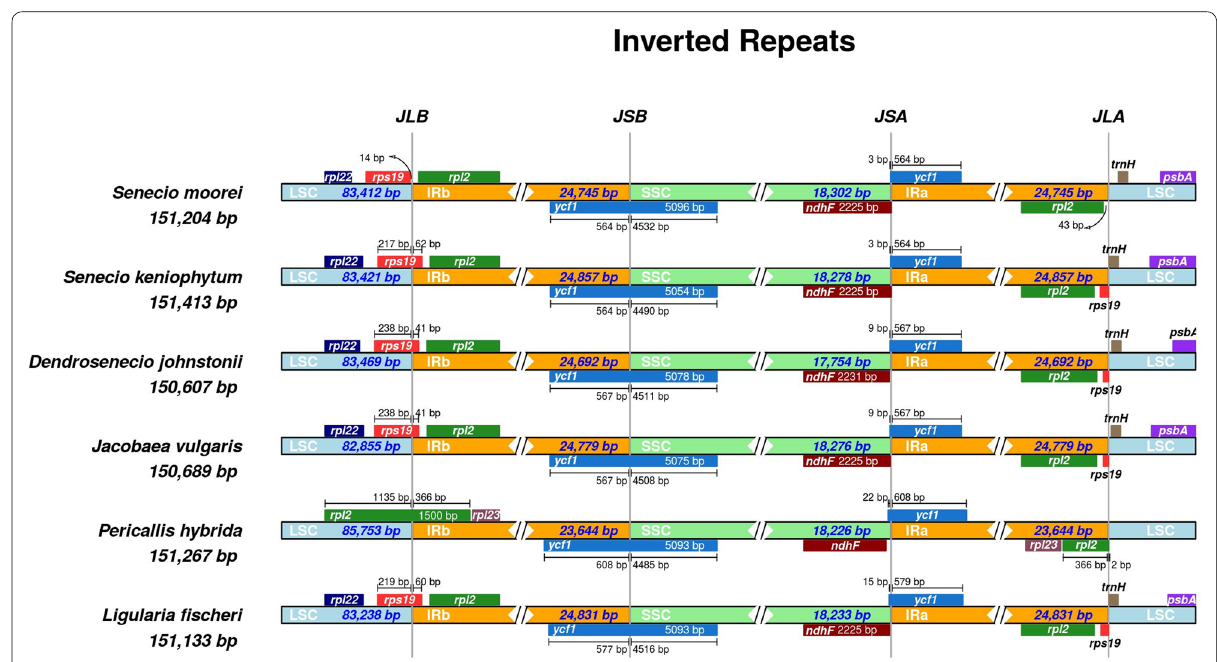
Fig. 4 Comparison of the large single copy, inverted repeats, and small single copy junction positions in six species of Senecioneae (Asteraceae). Genes adjacent to the junctions are shown as blocks of different colours